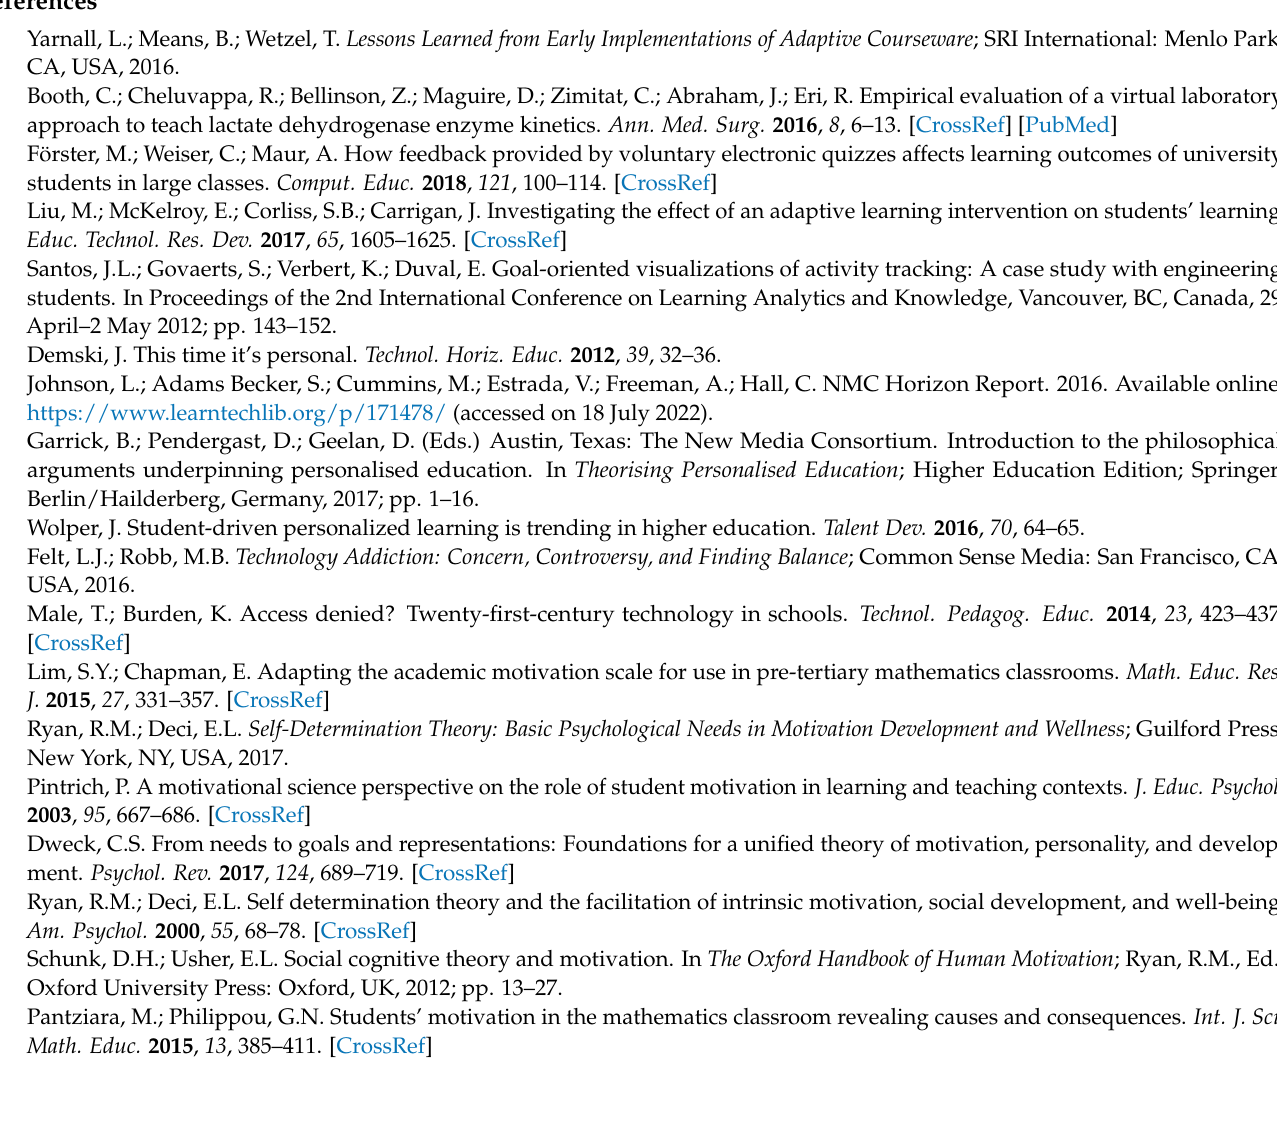
Figure A2. In this figure (after applying the adjusted scoring matrix), it is evident that a person higher on the AMTMS scale displays a higher probability of selecting a higher category. To illustrate, a person of 0 and 1 logit on the AMTMS scale would have a higher probability of selecting category 1 (“corresponds a little”) and category 2 (“corresponds moderately”) to this item, respectively.